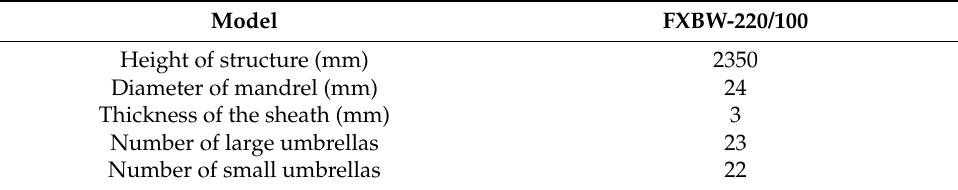
Table 1. Parameters of FXBW-220/100 composite insulator.